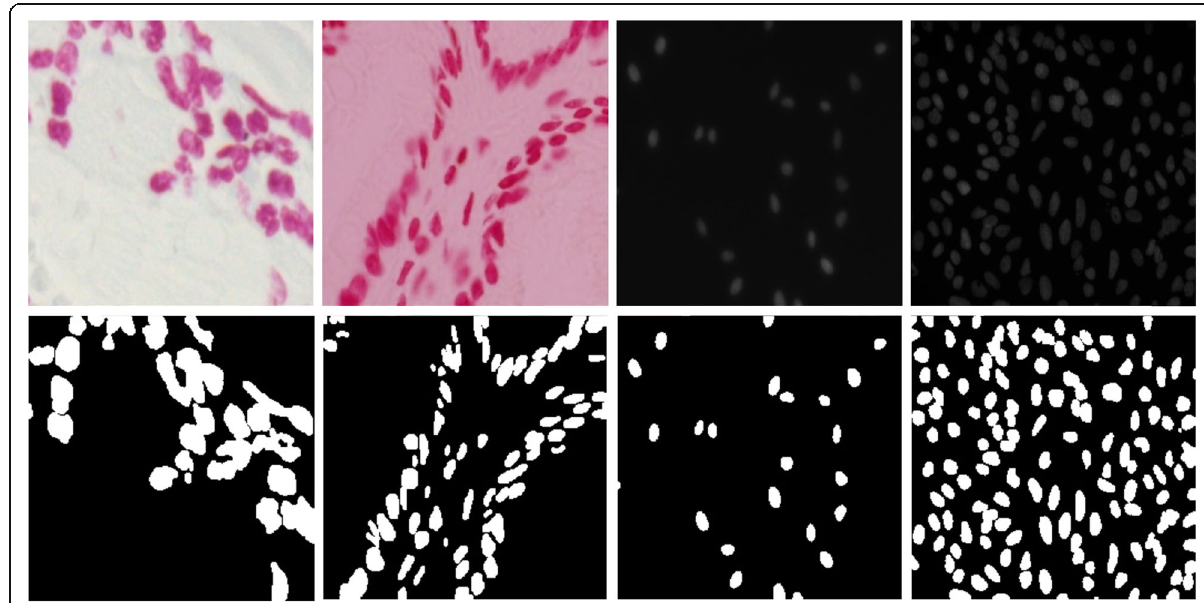
Fig. 8 Example input images with segmentation masks: the first row shows input samples and the pixel label annotated masks are shown in the second